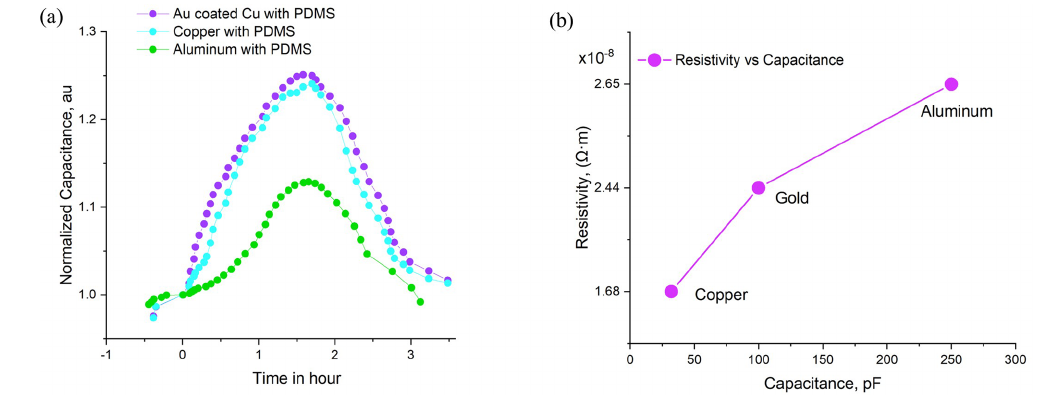
Figure 8. (a) Effect of different types of metal pads on blood sugar measurement by capacitance spectroscopy and (b) relation of capacitance to resistivity value of the metals.